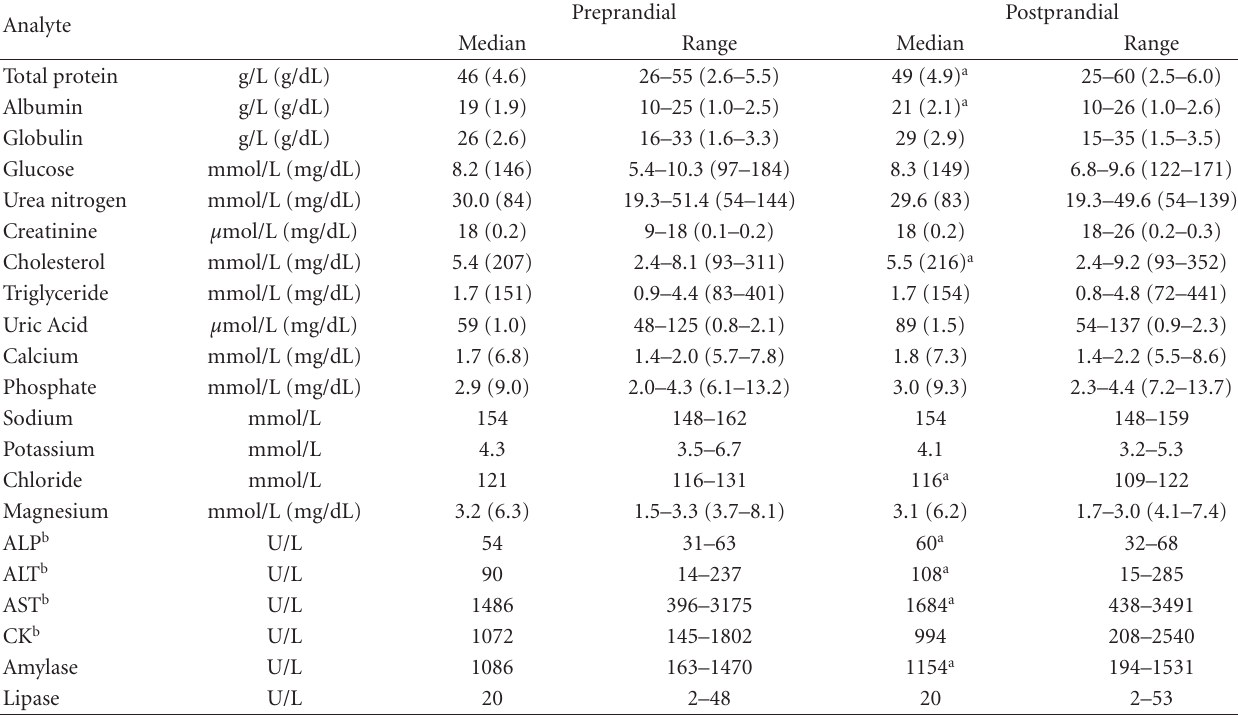
Table 3: Medians and ranges for preprandial and postprandial plasma biochemical values from juvenile green sea turtles ( n = 10). System International and conventional units (in parentheses) are